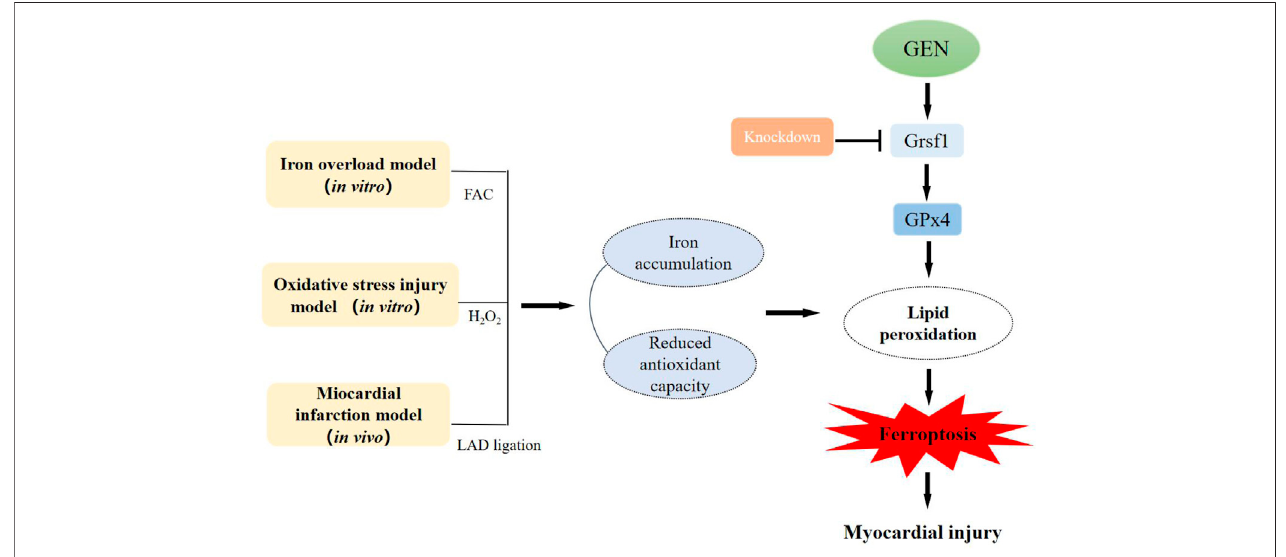
FIGURE 6 | The pathogenesis of myocardial ferroptosis and the protective mechanism of GEN against myocardial injury in vitro and in vivo .